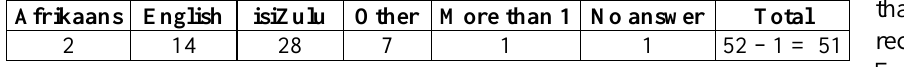
Table 3: Mother tongue language of learners Afrikaans